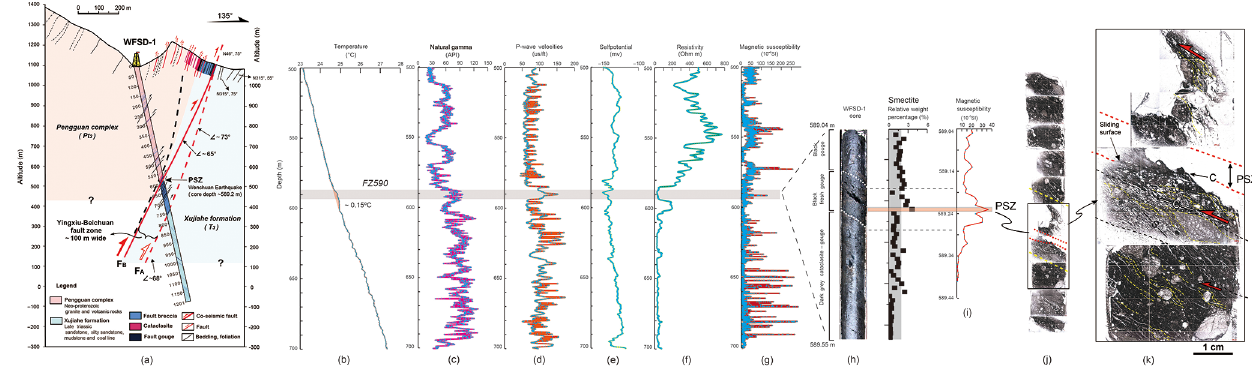
Figure 12. Cross section, logging, and core data of the WFSD-1. The physical anomalies in logging data (b–g) correspond to the fault gauge (h–k) related to the principle slip zone (PSZ) of the Wenchuan earthquake (Li et al., 2013).